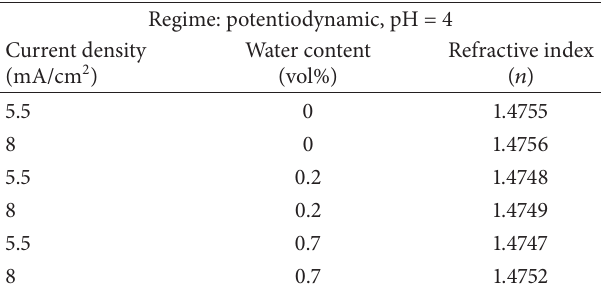
Table 2: Refractive index of the oxide films developed in potentio- dynamic mode.